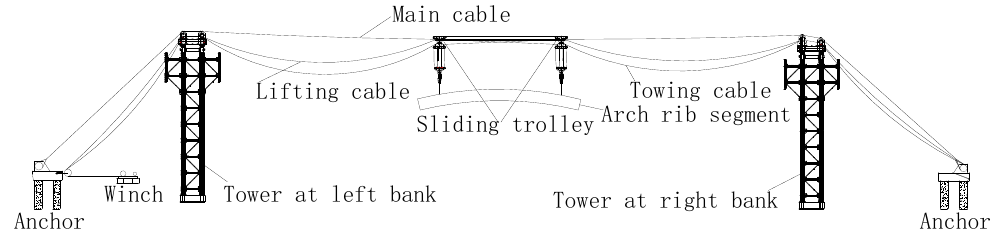
Figure 2. Simplified model of cable lifting system.